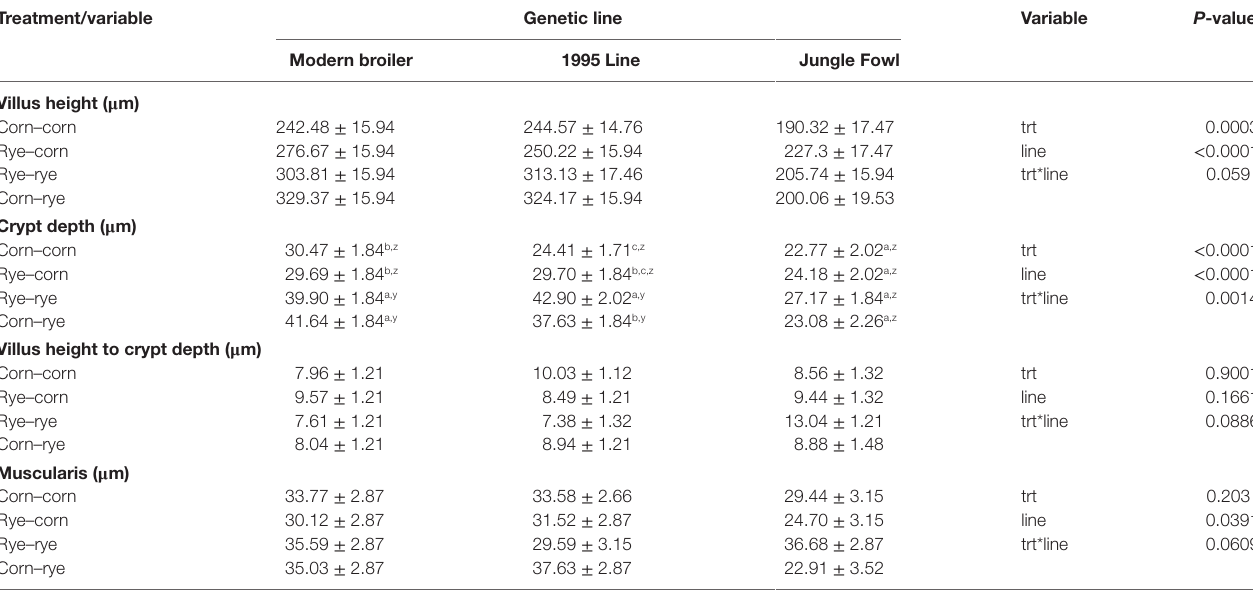
TaBle 5 | Evaluation of a nutritional rehabilitation model on morphometric analysis of duodenum in three genetic chicken lines fed rye or corn at varying time points at day 20 of age.